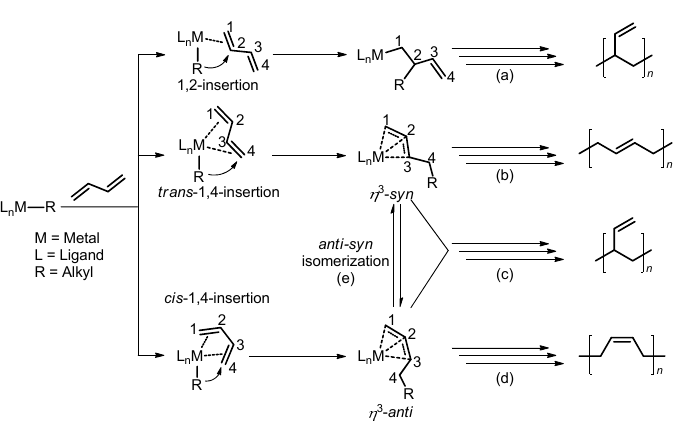
Figure 1. Optimized structures of cationic species thf A ( left ) and A ( right ) (distances in Å).